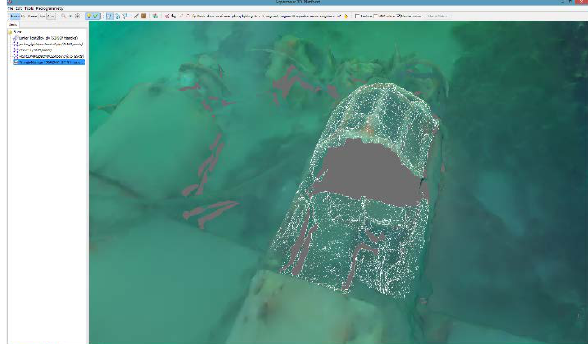
Figure 7 A surface extracted from a geodesic contour (Junker 55 aircraft underwater wreck, Marseille, France)